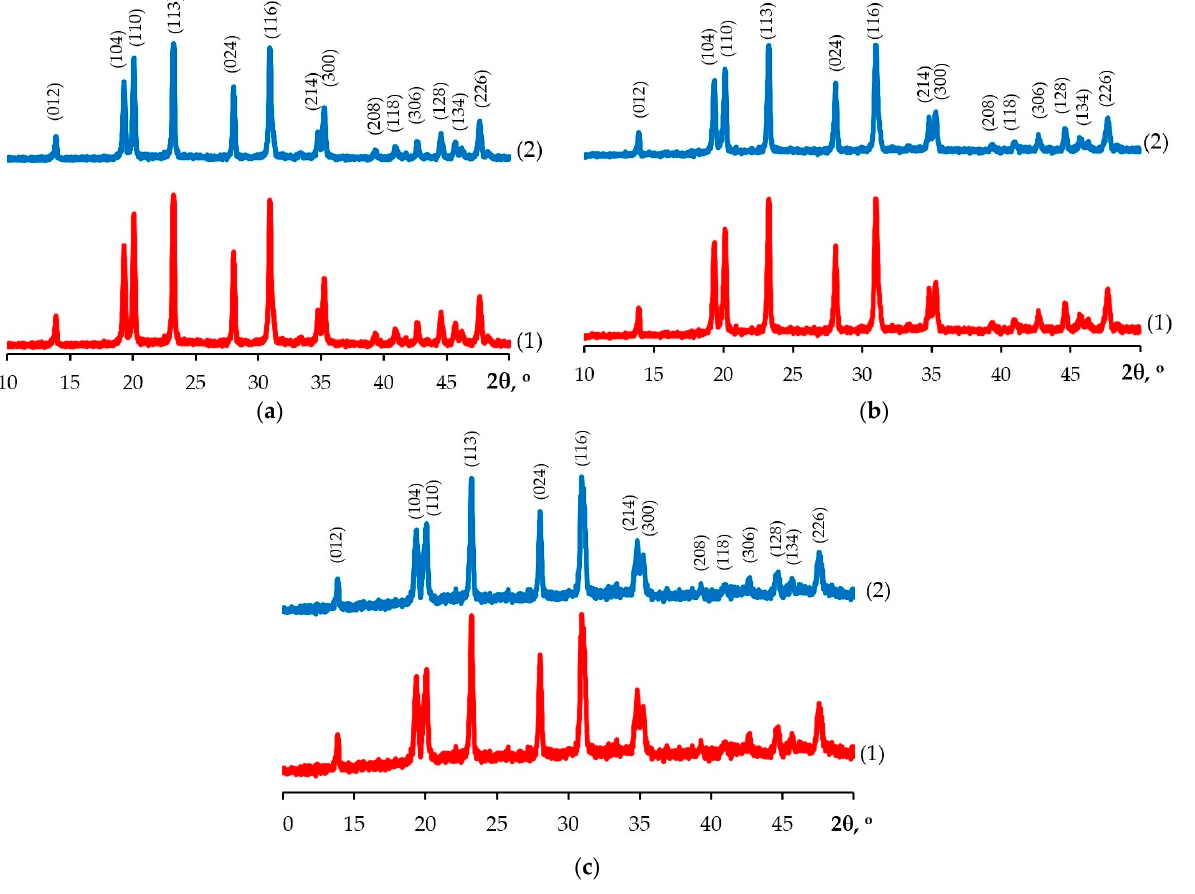
Figure 10. XRD data for Na 1.2 Zr 1.9 Co 0.1 (PO 4 ) 3 ( a ), Na 1.5 Zr 1.75 Co 0.25 (PO 4 ) 3 ( b ), and Na 2 Zr 1.5 Co 0.5 (PO 4 ) 3 ( c ) ceramics: line (1)—powders, line (2)—ceramics. Table 3. EDS analysis results of the ceramics Na 1+2x Zr 2-x Co x (PO 4 ) 3 . Ceramics